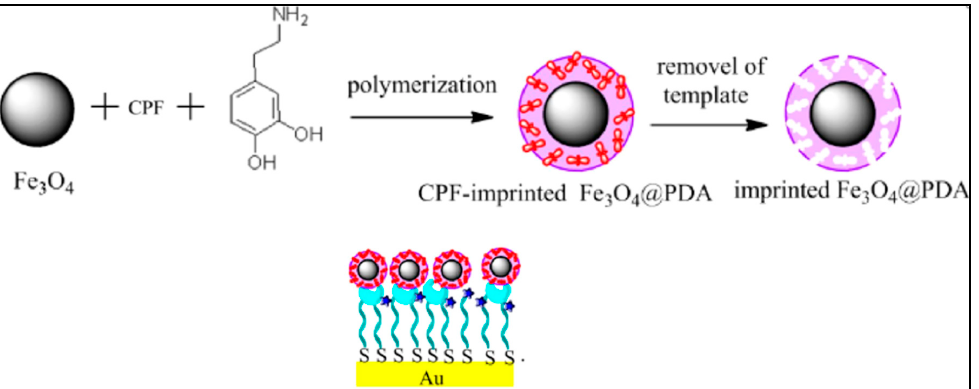
Figure 3. ( Top ) Schematic imprinted magnetic nanoparticle synthesis. ( Bottom ) Representation of imprinted nanoparticles attached to thiol ligands on a gold surface for sensing. Reprinted with per- mission from the reference [36]. Copyright 2019 American Chemical Society.